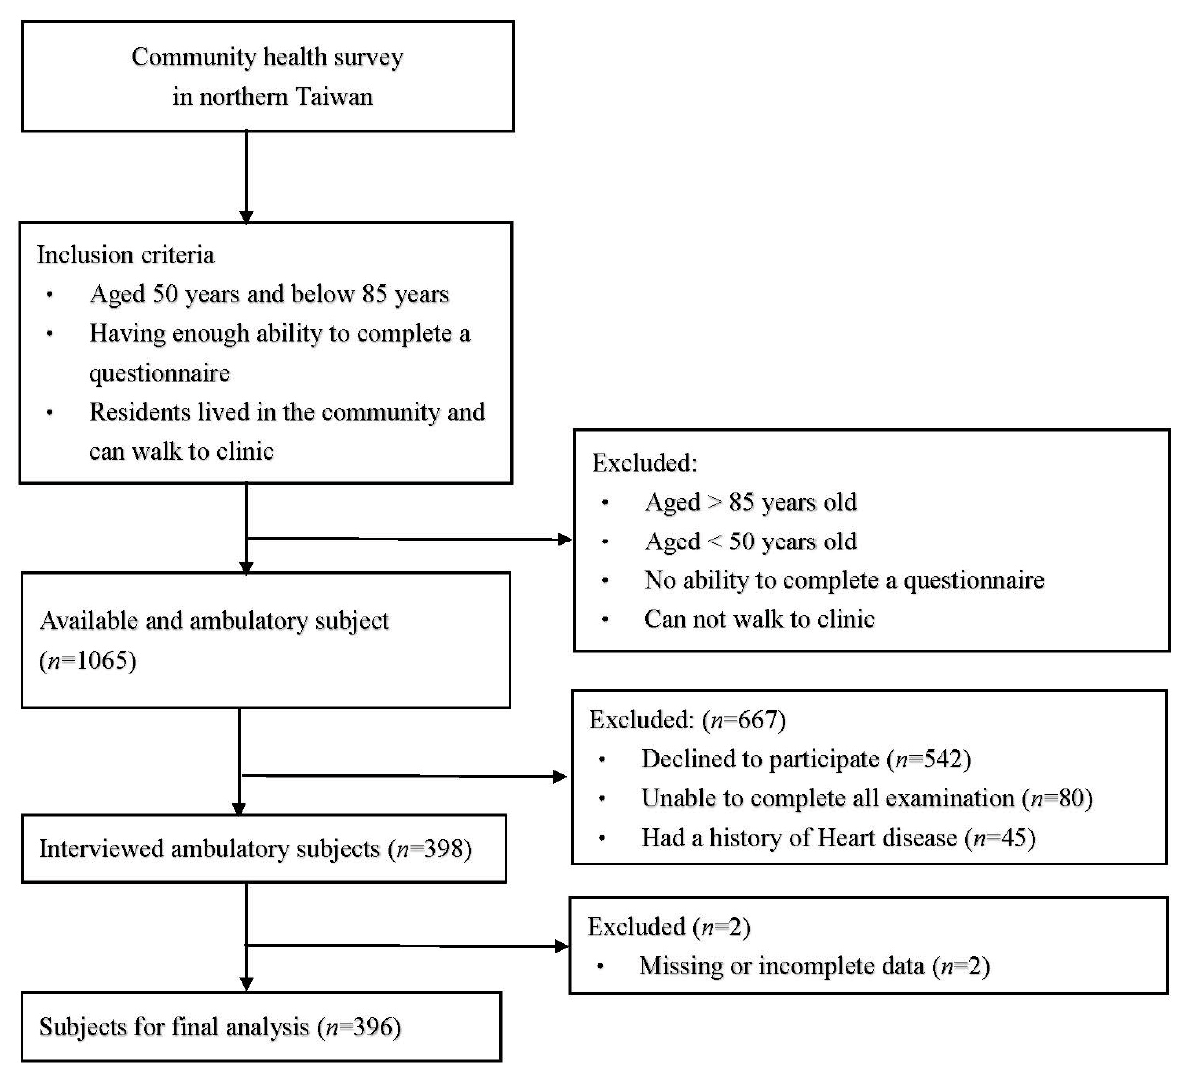
Figure 1. Flowchart of recruitment .